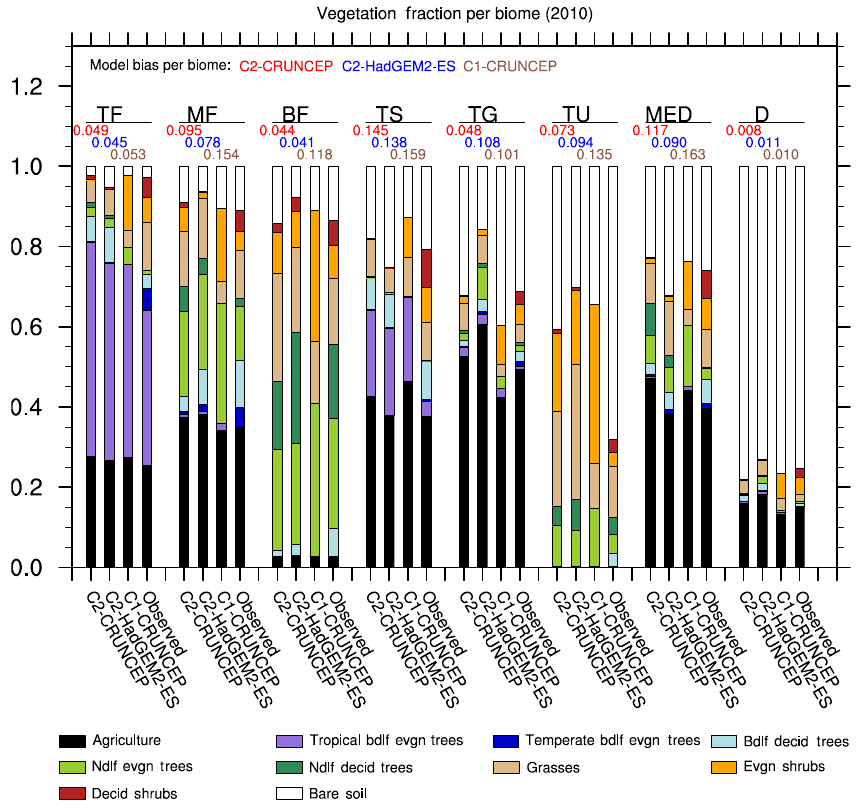
Figure 2. Comparison of PFT distribution by biome in JULES-C2 forced with CRUNCEP-v6 and HadGEM2-ES climates, compared to JULES-C1 with CRUNCEP-v6 climate and to the observed distribution from ESA LC-CCI. The biomes are as follows: tropical forests (TF); temperate mixed forests (MF); boreal forests (BF); tropical savannah (TS); temperate grasslands (TG); tundra (TU); Mediterranean woodlands (MED); and Deserts (D). Biome distributions are shown in Fig. S9. The black bars represent agricultural land. Model biases per biome are from Eq.